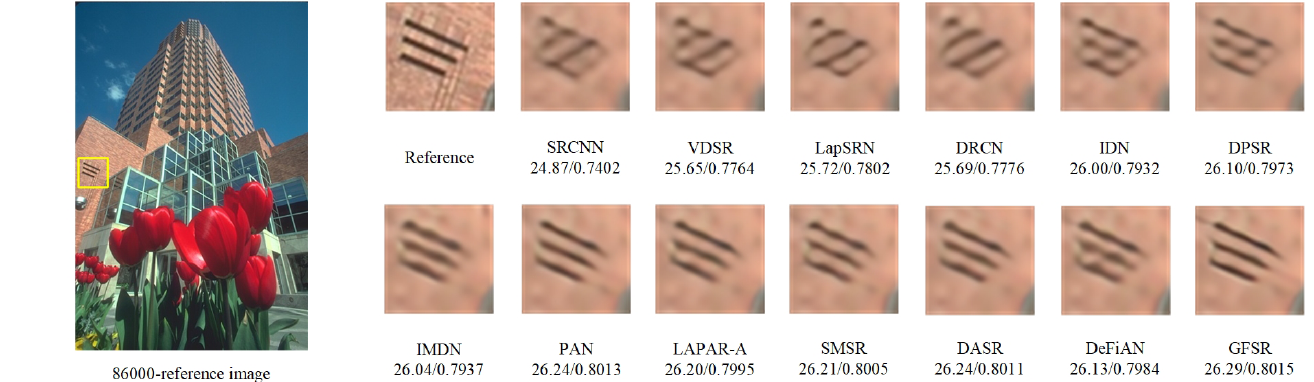
Figure 10. Visual comparison of super-resolution results of ‘86000’ (BSD100) obtained by different SR algorithms with scaling factor ×4.